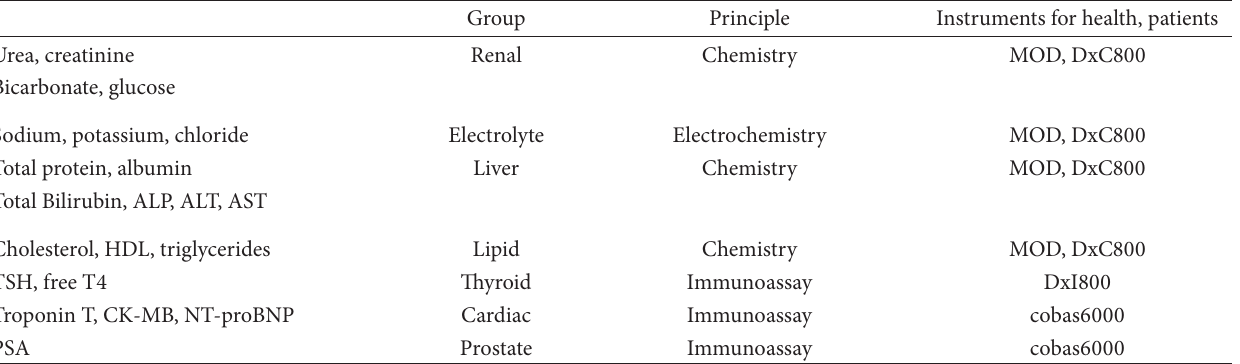
Table 1: Tests associated with instrument platforms.